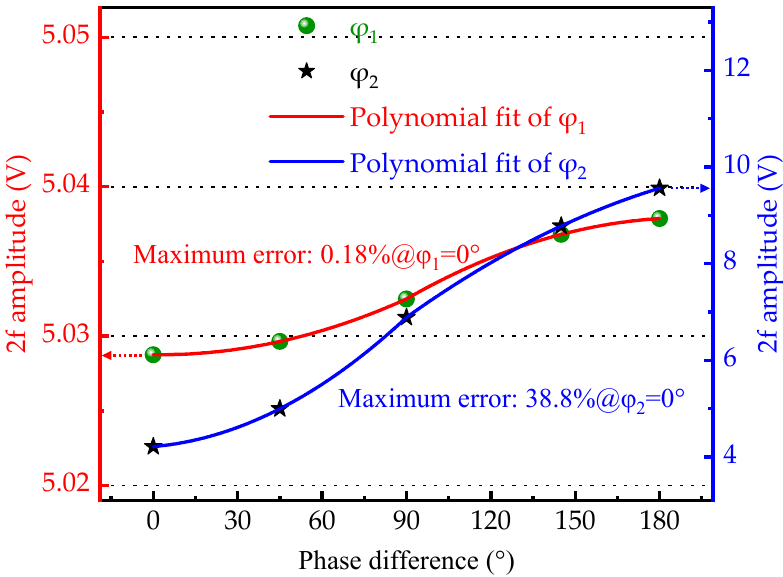
Figure 3. Influence of ϕ 1 and ϕ 2 change on the amplitude of 2f from the overlapping absorption lines.